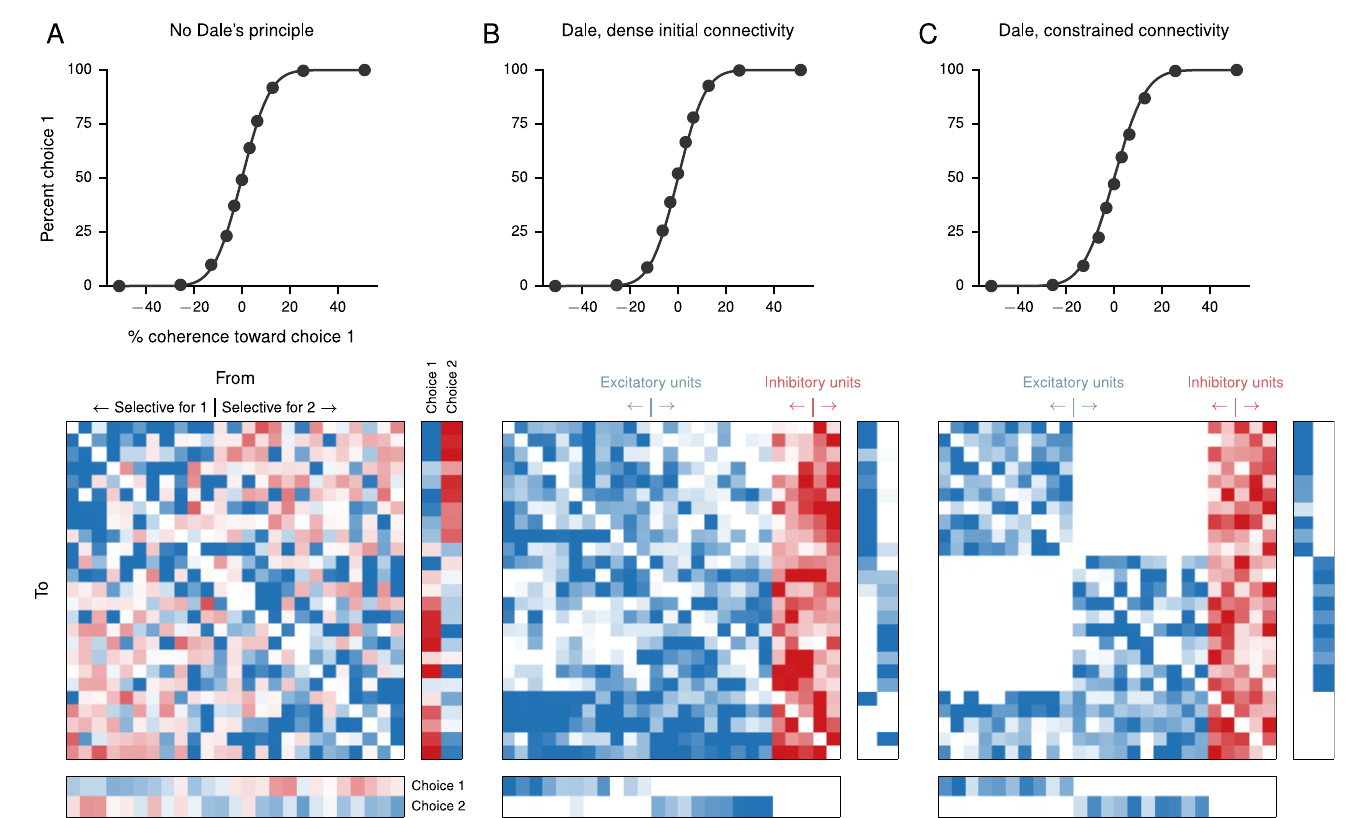
Fig 3. Perceptual decision-making networks with different constraints. (A) Psychometric function (percent choice 1 as a function of signed coherence) and connection weights (input, upper-right; recurrent, upper-left; and output, lower) for a network in which all weights may be positive or negative, trained for a perceptual decision-making task. Connections go from columns ( “ pre-synaptic ” ) to rows ( “ post-synaptic ” ), with blue representing positive weights and red negative weights. Different color scales (arbitrary units) were used for the input, recurrent, and output matrices but are consistent across the three networks shown. In the psychometric function, solid lines are fits to a cumulative Gaussian distribution. In this and the networks in B and C , self-connections were not allowed. In each case 100 units were trained, but only the 25 units with the largest absolute selectivity index (Eq 30) are shown, ordered from most selective for choice 1 (large positive) to most selective for choice 2 (large negative). (B) A network trained for the same task as in A but with the constraint that excitatory units may only project positive weights and inhibitory units may only project negative weights. All input weights were constrained to be excitatory, and the readout weights, considered to be “ long-range, ” were nonzero only for excitatory units. All connections except self-connections were allowed, but training resulted in a strongly clustered pattern of connectivity. Units are again sorted by selectivity but separately for excitatory and inhibitory units (20 excitatory, 5 inhibitory). (C) Same as B but with the additional constraint that excitatory recurrent units receiving input for choice 1 and excitatory recurrent units receiving input for choice 2 do not project to one another, and each group sends output to the corresponding choice.